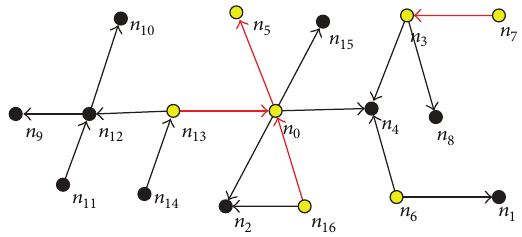
Figure 1: Software dependency